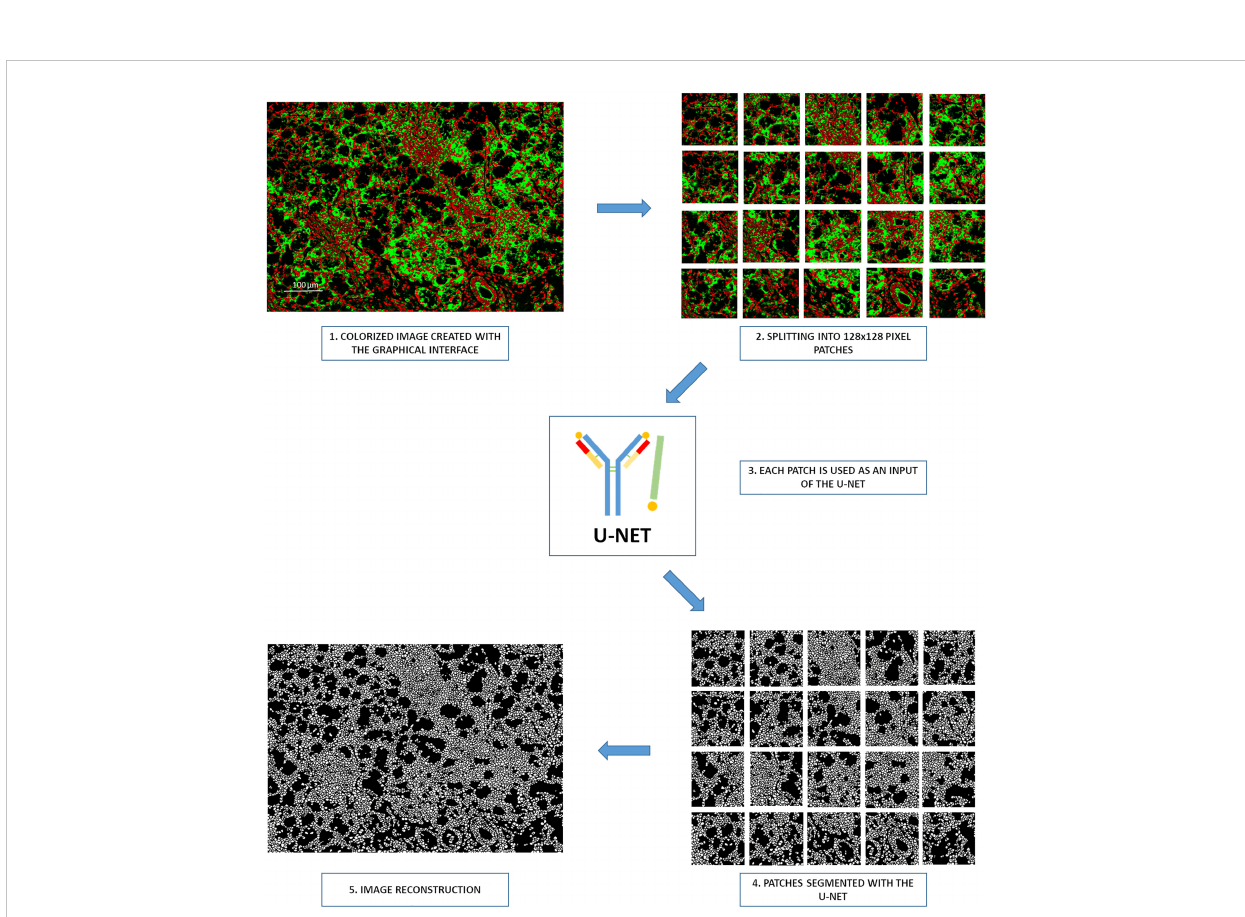
FIGURE 4 Processing steps for the Segmentation button of the graphical interface. 1. Creation of a colorized image by the graphical interface, 2. Splitting of images in 128×128 pixel patches, 3. Each patch serves as an input of the neural network, 4. Segmentation of all patches with the YOUPI tool, 5. Reconstruction of the entire image with the segmented